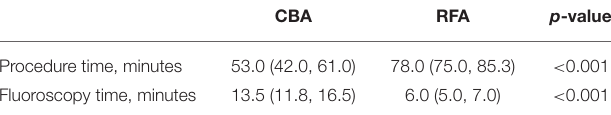
TABLE 2 | Procedural and fluoroscopy time of the study